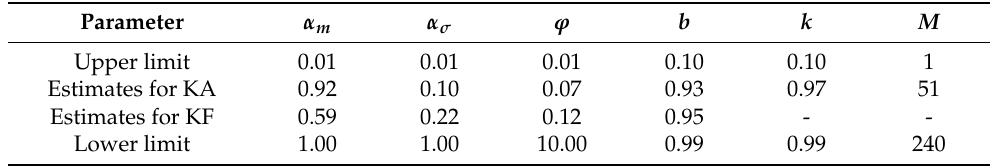
Table 2. Parameter of the KRE and RAPI